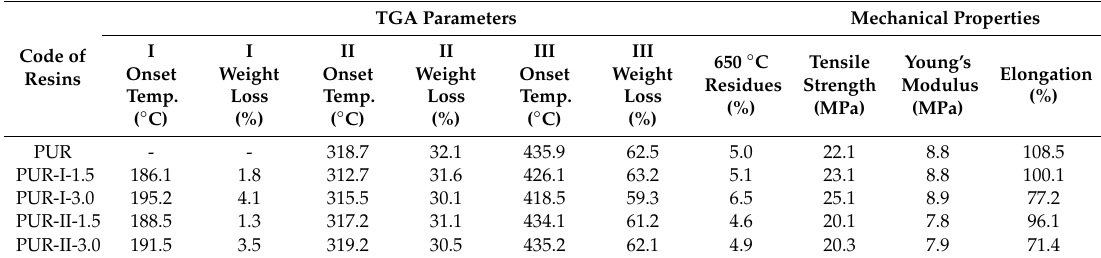
Table 2. TGA parameters and mechanical properties of various PUR.